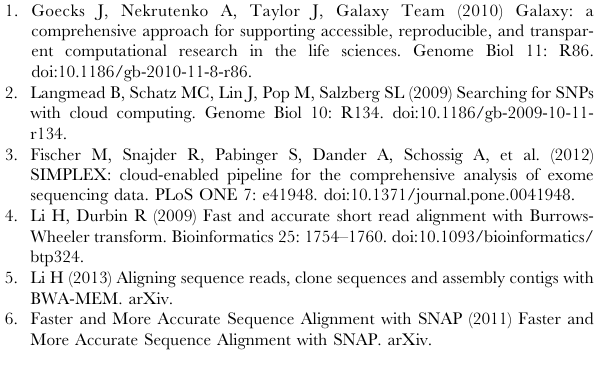
Figure S1 The STORMSeq webserver allows users to set parameters and start the pipeline using a graphical interface. Figure S2 Time and cost estimates (spot pricing) for a personal exome sequence (90M reads, or 45X coverage)